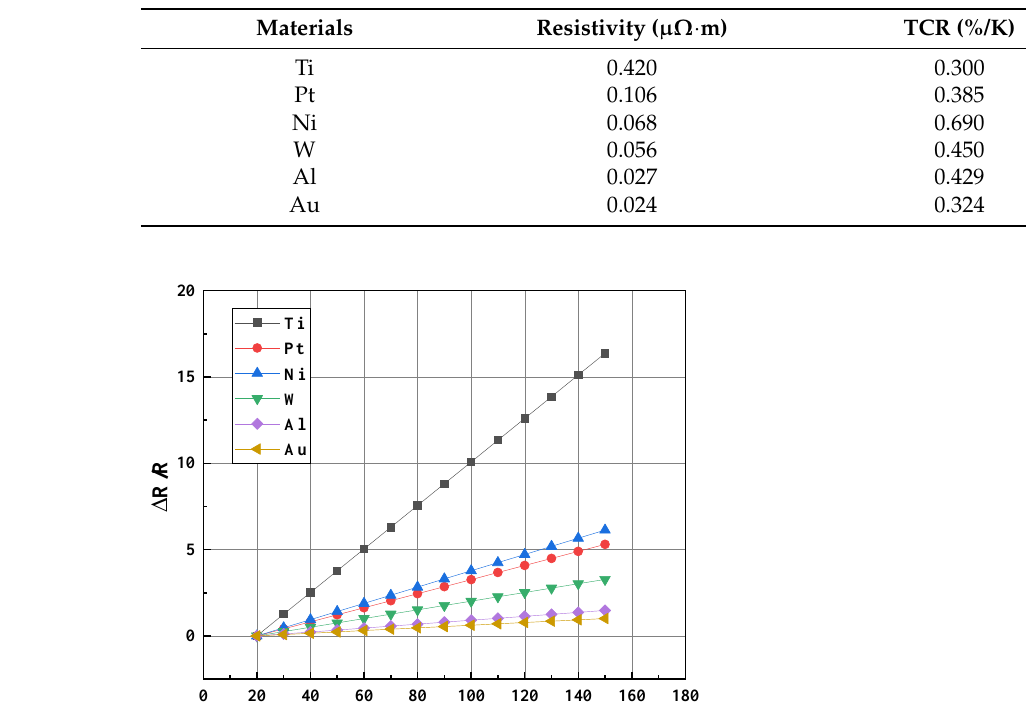
Table 1. Resistivity and TCR of several metallic materials.